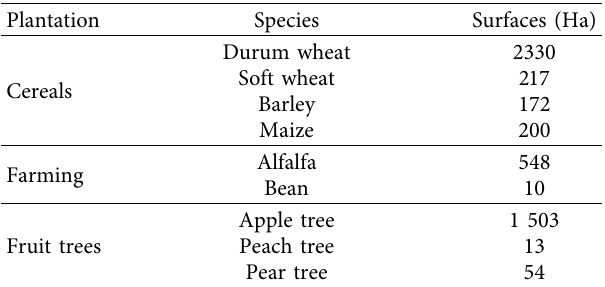
Figure 1: Studied habitats in Midelt province between 2015 and 2018. Table 1: Principal agricultural plantations in Midelt